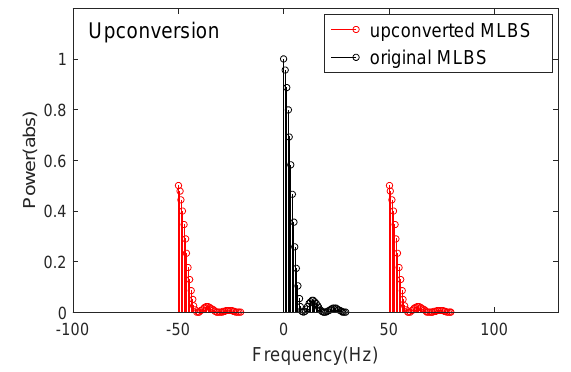
Figure 4: MLBS with 50 Hz upconversion. The equation shows that the translated signal under- goes a 6 dB loss (a 50 percent reduction) at ω , and 12 dB loss (a 75 percent reduction) at the sideband frequencies as dictated by the factors 1 / 2 and 1 / 4.